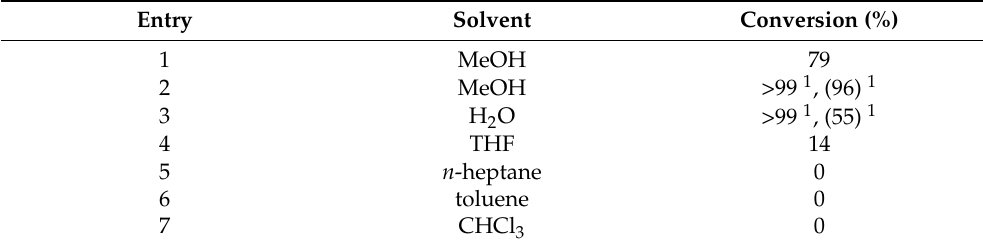
Table 4. Hydrogenation of nitrobenzene: optimization of the solvent. Reaction conditions: